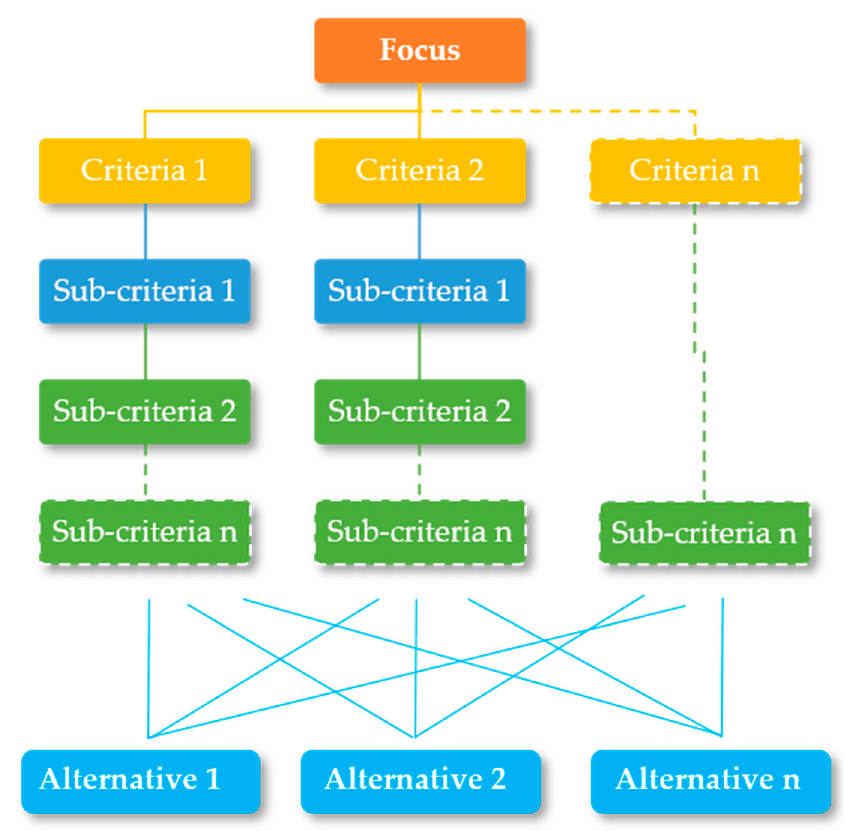
Figure 2. Schematic overview of the analytical hierarchy process.